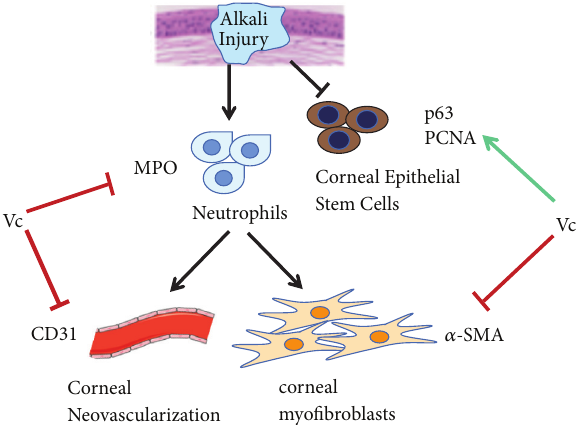
Figure 6: The mechanism of Vc for promoting corneal epithelial wound healing and inhibiting corneal neovascularization, corneal inflammation, and corneal fibrosis. “ ⟶ ” means promoting effect. “ · ” means inhibiting